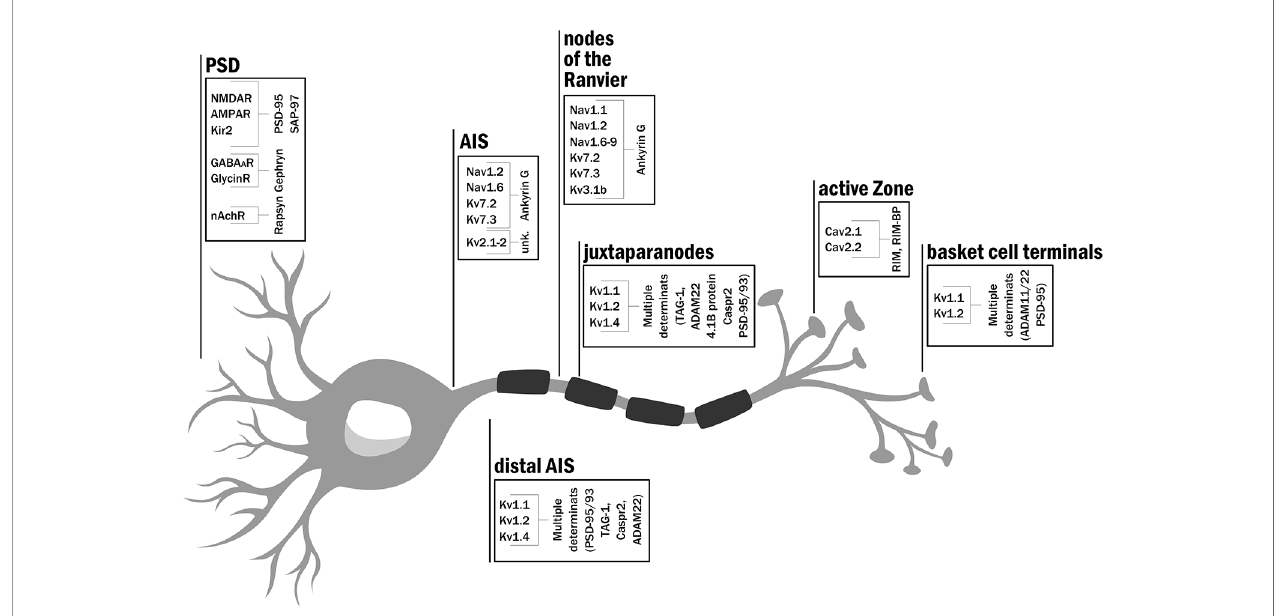
FIGURE 1 | Clustering geography: the distribution of ion channels and scaffold proteins along the neuron. Schematic representation of a typical neuron specifying the type of ion channel and scaffold proteins targeted and clustered to the axon initial segment, node of Ranvier, active zone and at the postsynaptic densities (in dendrites). A full reference list supporting the indicated location for each channel subtype is given in SI Text 1